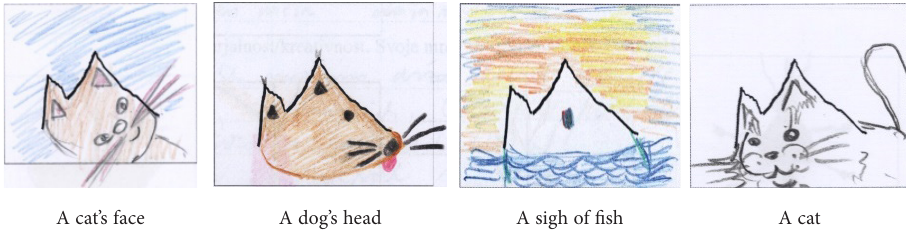
Figure 27. The creative task: interpretation of Fragment 4 – animals (source: testingmom.com, 2020) In the process of association only one third-year student from Lithuania envisaged an ani- mal in the given fragment. The number of animals in the process of interpretation grew to 8.7% (n = 10). Out of 10 animals there were 4 cats, 2 dogs, 2 fish, 1 fox and a shark (Figure 27).